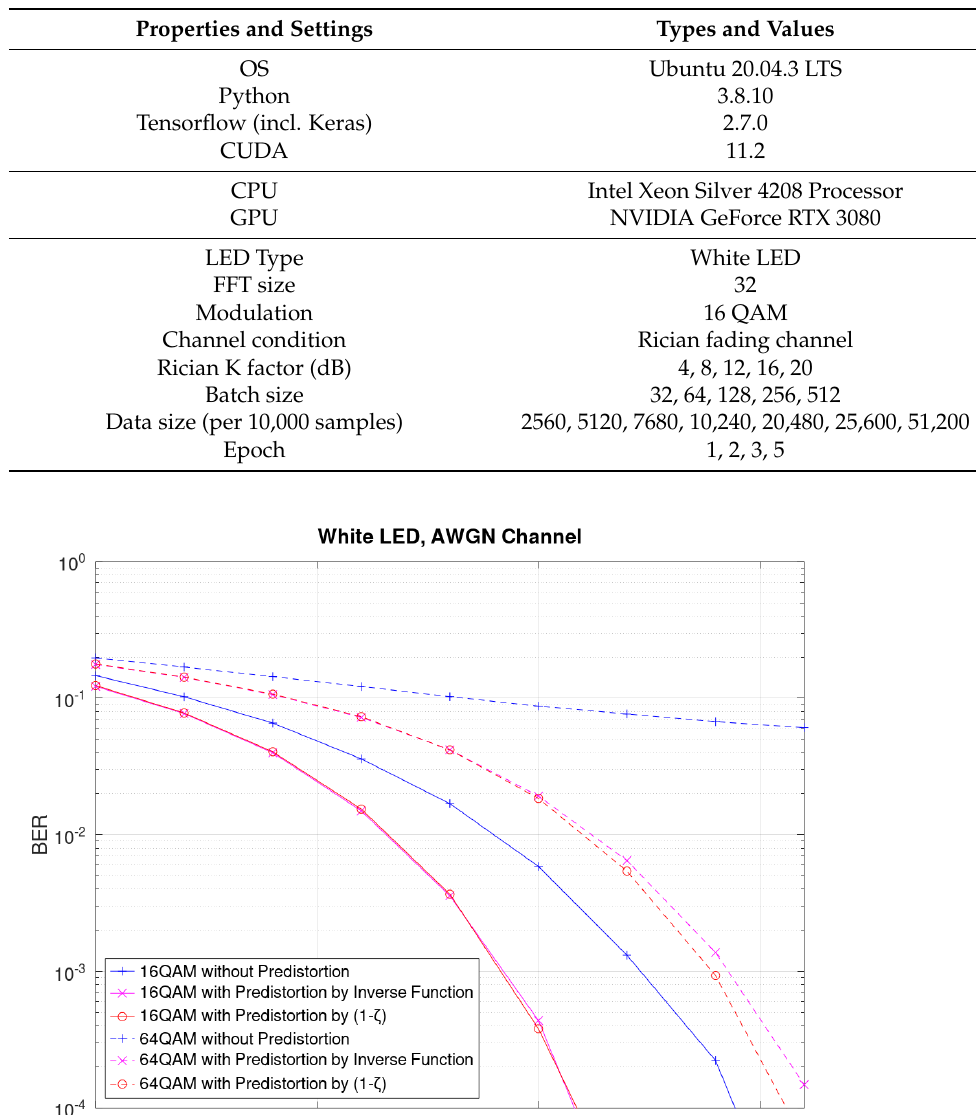
Table 1. Experiment properties and settings for VLC BLSTM experiments.